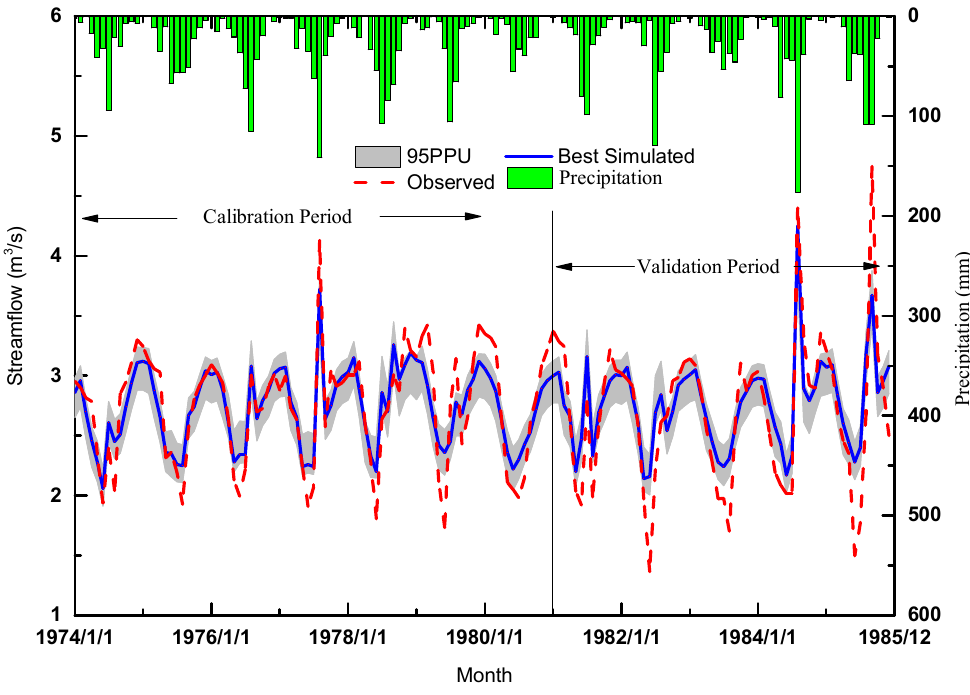
Figure 5. Observed and simulated monthly streamflow of the Hailiutu River basin. Table 3. The performance of the SWAT model during the calibration and validation periods.